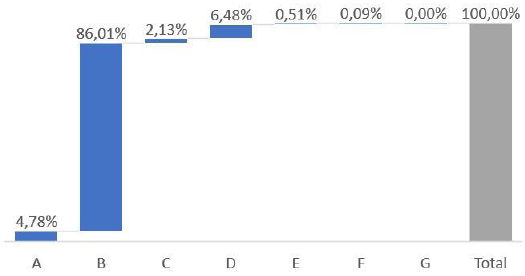
Figure 14. Destination of particles with half ingot inserted (A= still in transit in the zinc bath; B= precipitated on the surface of the pot; C= precipitated on the surface of the internal snout bath; D= found the strip in region 1; E= found the strip in region 2; F= found the strip in region 3; G= found the strip in region 4).